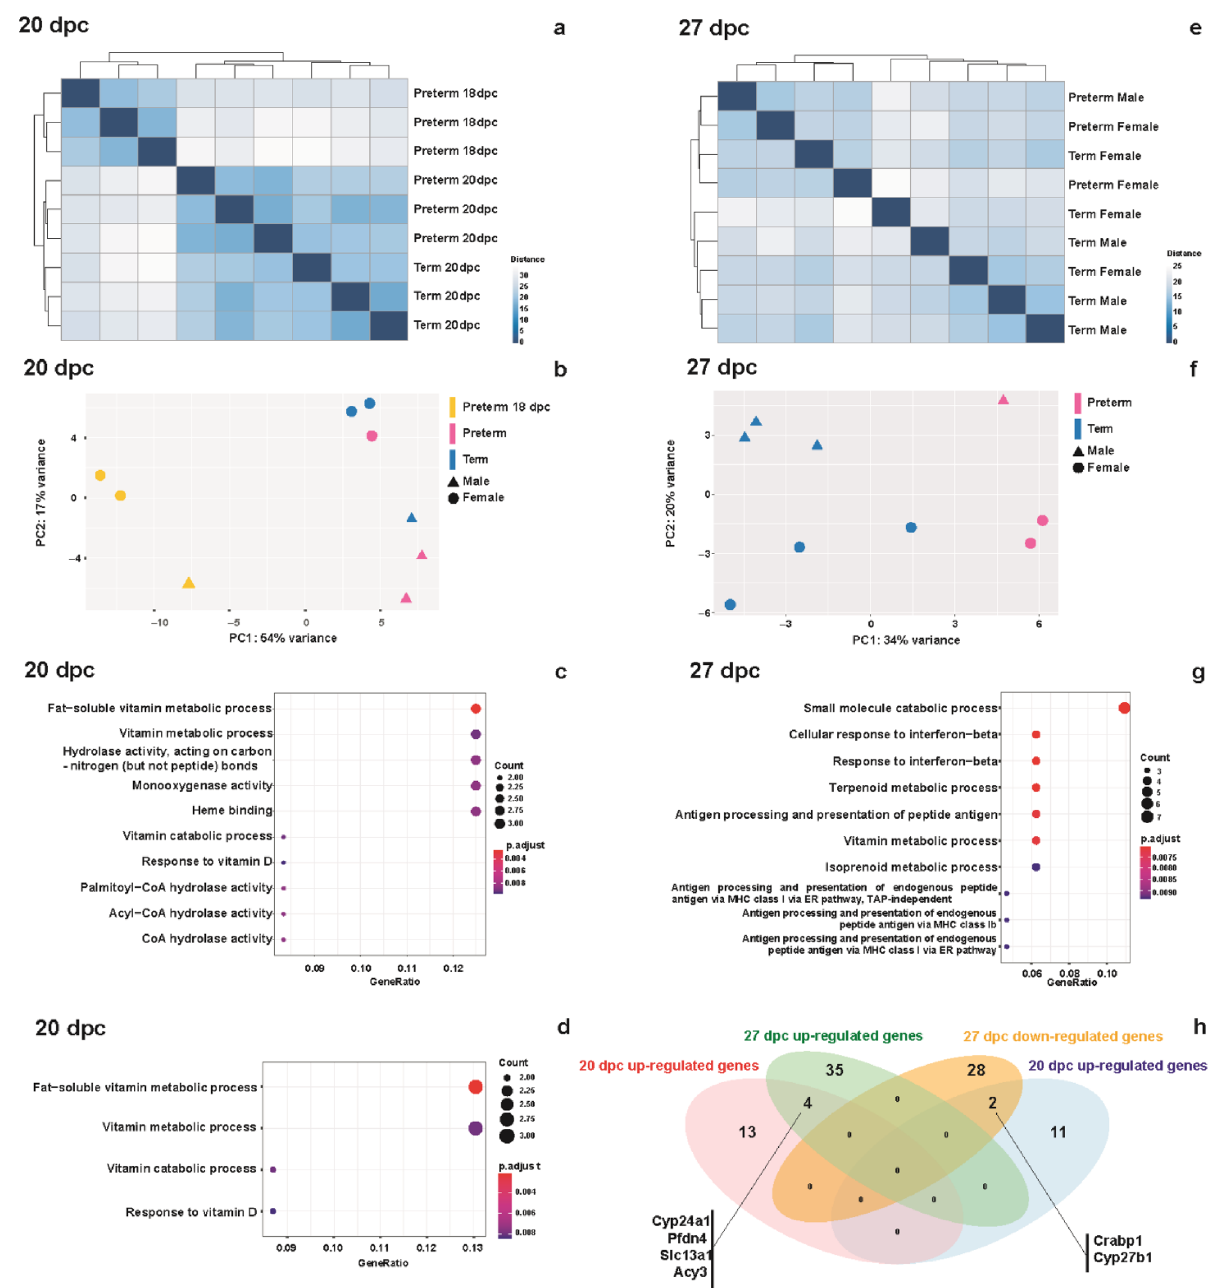
Figure 2. Preterm birth results in early transcriptional alterations in the kidney. ( a ) Hierarchical clustering analysis on RNA-seq data revealed the expression profiles clustering into three groups at the early time point (18 and 20 dpc), with apparent differences between the 18 dpc animals from those at 20 dpc. ( b ) A principal component analysis also showed clear dissociations between 18 and 20 dpc expression profiles. Among the 20 dpc animals, there was sex-dependent clustering. Gene Ontology (GO) enrichment analyses ( c ) and ( d ) on differentially expressed genes (DEGs) between preterm and term 20 kidneys revealed enrichment of the fat-soluble vitamin related pathways in an analysis adjusted ( d ) or not adjusted ( c ) for sex. ( e ) Hierarchical clustering analysis on the expression profiles of 27 dpc animals. ( f ) A principal component analysis of 27 dpc expression data also showed dissociations between preterm and term expression profiles and a sex-dependent clustering. ( g ) GO enrichment analysis on DEGs of 27 dpc without adjusting for sex showed small catabolic processes as the top GO term. ( h ) A Venn diagram showed overlaps of DEGs between 20 and 27 dpc analyses. Six overlapped DEGs were identified (4 up-regulated genes and 2 down-regulated genes) with the same direction of the alterations at 20 and 27